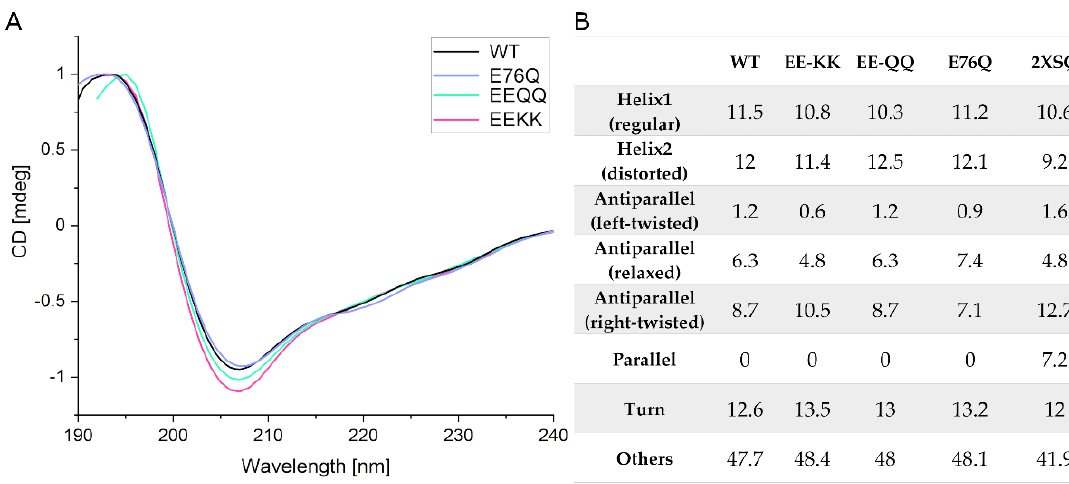
Figure 2. ( A ) CD spectra for wild-type hNudt16 and studied mutants. ( B ) Contribution of secondary structures in the polypeptide chain obtained from CD measurements (calculated in BeStSel) in comparison to the corresponding crystal structure.